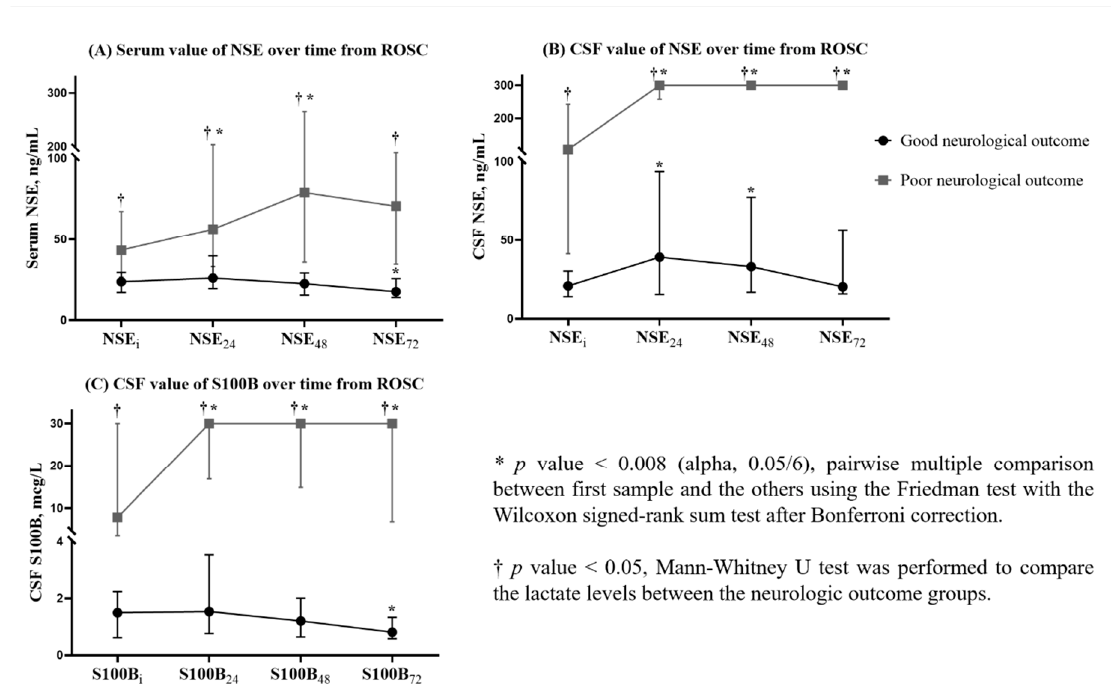
Figure 2. Changes in the concentrations of ( A ) serum NSE, ( B ) CSF NSE, and ( C ) CSF S100B measured immediately and at 24, 48, and 72 h after ROSC, categorized according to neurological outcomes. The line and the plot indicate the median levels and interquartile range of biomarkers. The concentrations of all biomarkers measured at all time points were significantly higher in those with poor neurological outcome than in those with good neurological outcome. CSF, cerebrospinal fluid; ROSC, return of spontaneous circulation; NSE, neuron-specific enolase concentration measured immediately (NSE i ) and at 24 (NSE 24 ), 48 (NSE 48 ), and 72 h (NSE 72 ) after the return of spontaneous circulation; S100B, S100B protein concentration measured immediately (S100B i ) and at 24 (S100B 24 ), 48 (S100B 48 ), and 72 h (S100B 72 ) after the return of spontaneous circulation.